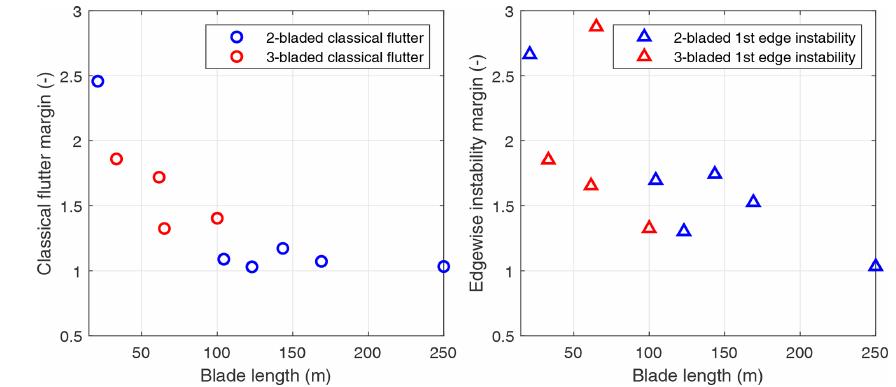
Figure 8. Classical flutter and edgewise instability margins for various wind turbine blade series were analyzed. The blue markers are three-bladed turbines, and the red markers show the two-bladed downwind SUMR series of